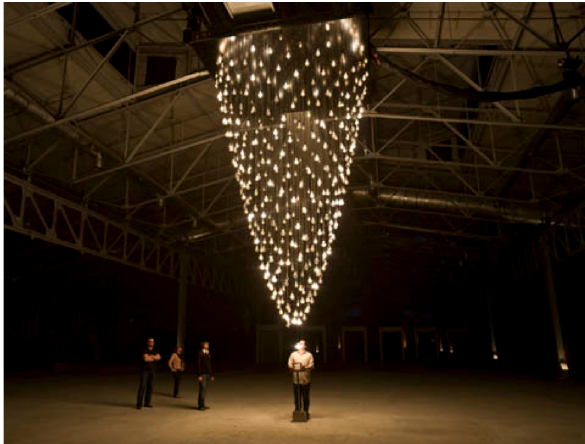
Figure 3 | Rafael Lozano-Hemmer, Pulse Spiral , 2008. Photo by Antimodular